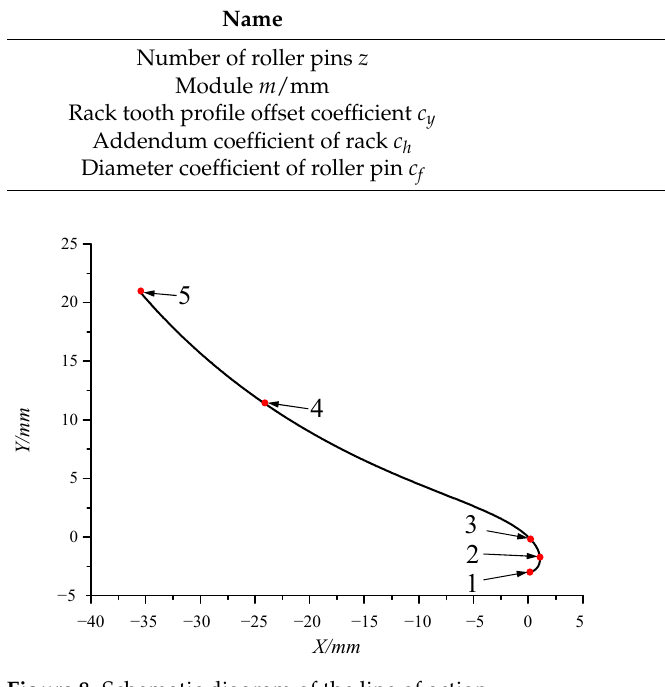
Figure 8. Schematic diagram of the line of action.